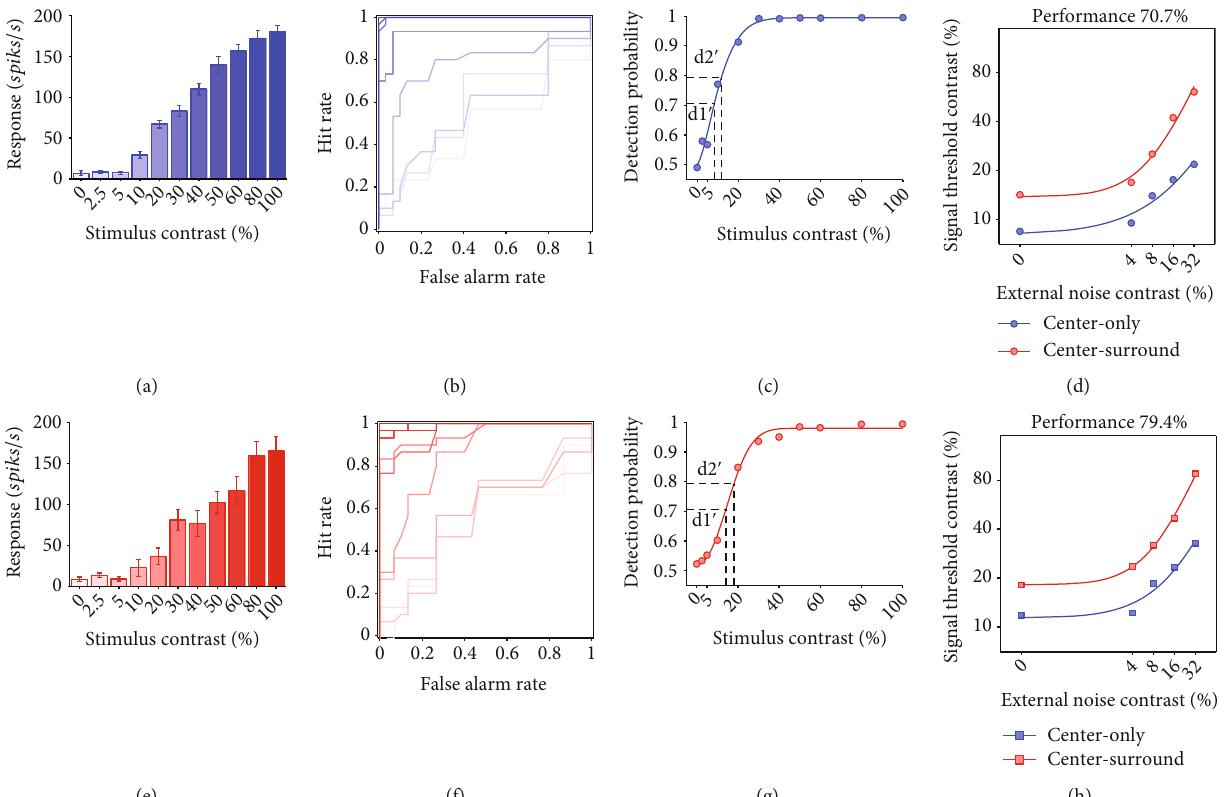
Figure 3: A sample cell showing the ROC analysis for measurement of the contrast threshold that the V1 neuron can respond to the visual stimuli at two performance criteria ( d1 ′ = 70 : 7 % and d2 ′ = 79 : 4 % ) with and without the presence of surround stimuli. (a, e) Contrast response functions showing the mean neuronal response to repeated presentation ( 6 × 5 trials) of visual stimuli with di ff erent luminance contrast (0, 0.025, 0.05, 0.1, 0.2, 0.3, 0.4, 0.5, 0.6, 0.8, and 1.0, as indicated by the color gradient) at an external noise level of 0 without (a) and with (e) surround stimuli. (b, f) ROC method shown by the hit rate versus false alarm rate for neuronal response value distribution at di ff erent stimulus contrasts compared with that of baseline response without (b) and with (f) surround stimuli. (c, g) showing the probability of the neuron in detection of visual stimuli with di ff erent contrasts without (c) and with (g) surround stimuli. The solid curves represent the best fi ts of detection probability versus stimulus contrast functions with a Weibull equation. The dashed lines indicate the signal contrast threshold (TC) at two performance criterion of d1 ′ and d2 ′ , respectively. (d, h) TC versus external noise contrast (TvC) functions at performance criterion 70.7% (d) and 79.4%